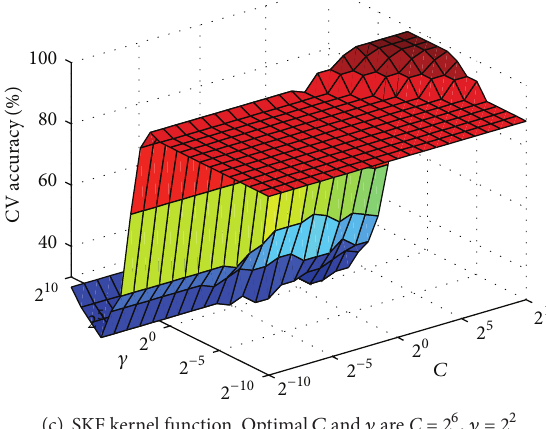
(a) Polynomial kernel function ( 𝑑 = 3 ). Optimal 𝐶 and 𝛾 are C = 2 −2 , 𝛾 = 2 10